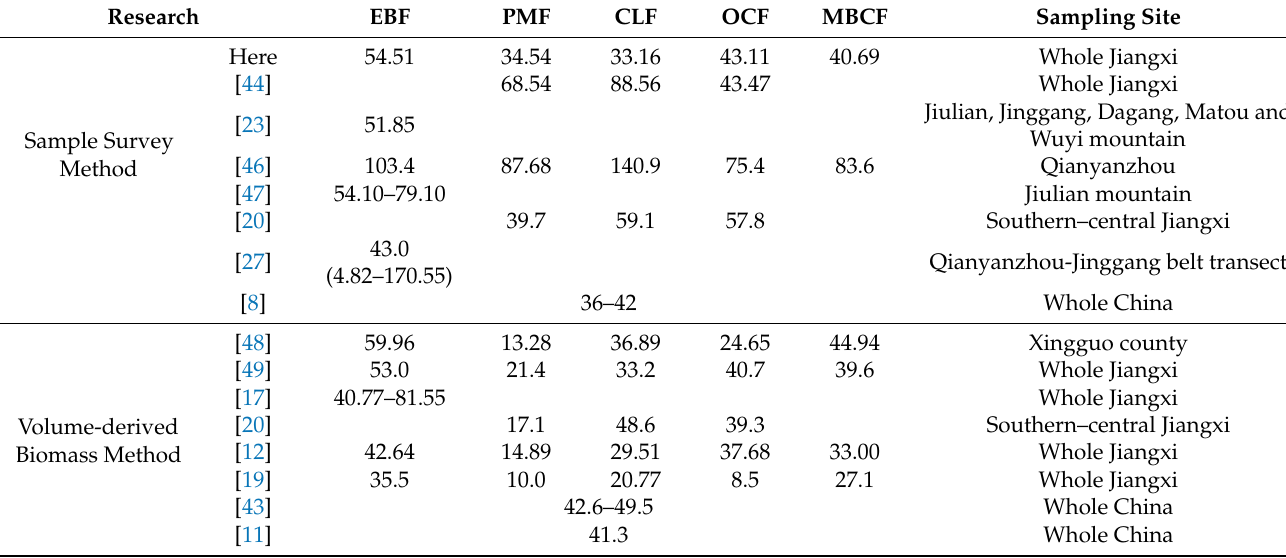
Table 11. Comparative analysis with previous research on vegetation carbon density